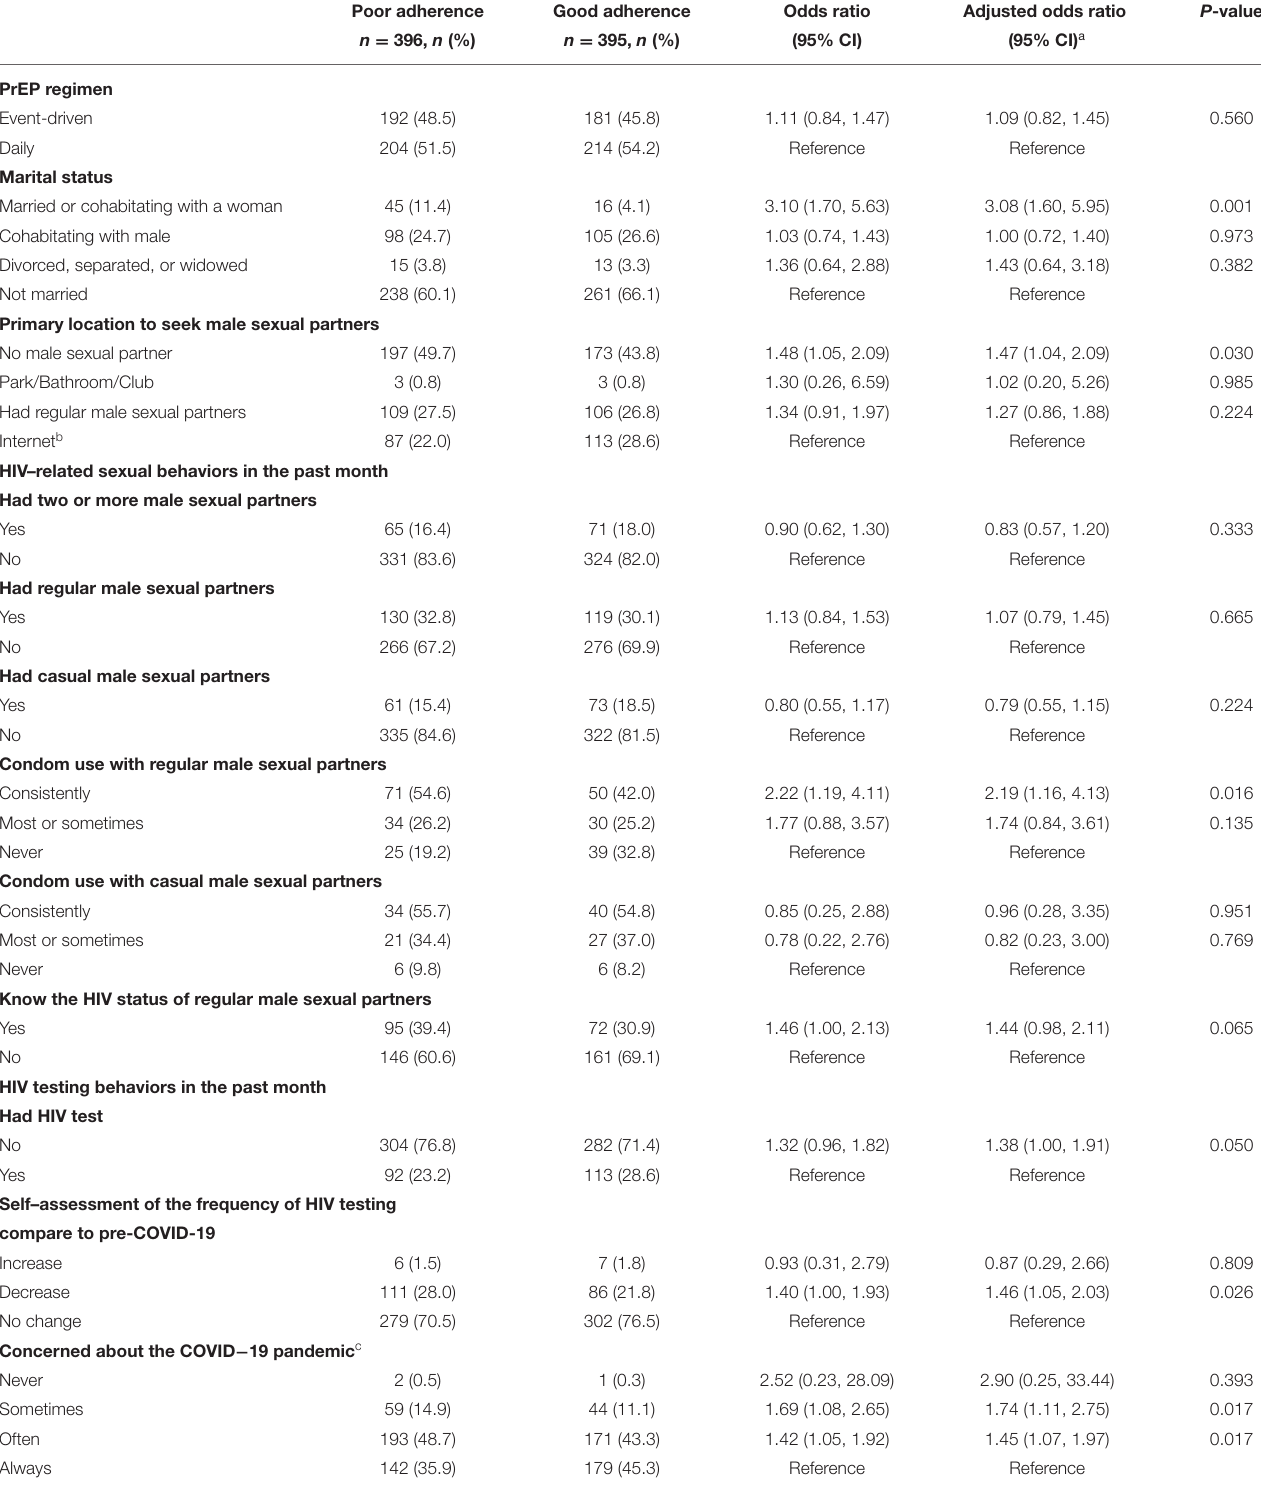
TABLE 3 | Factors correlated with poor adherence to PrEP among Chinese MSM PrEP users during the COVID-19 ( N = 791). Poor adherence Good